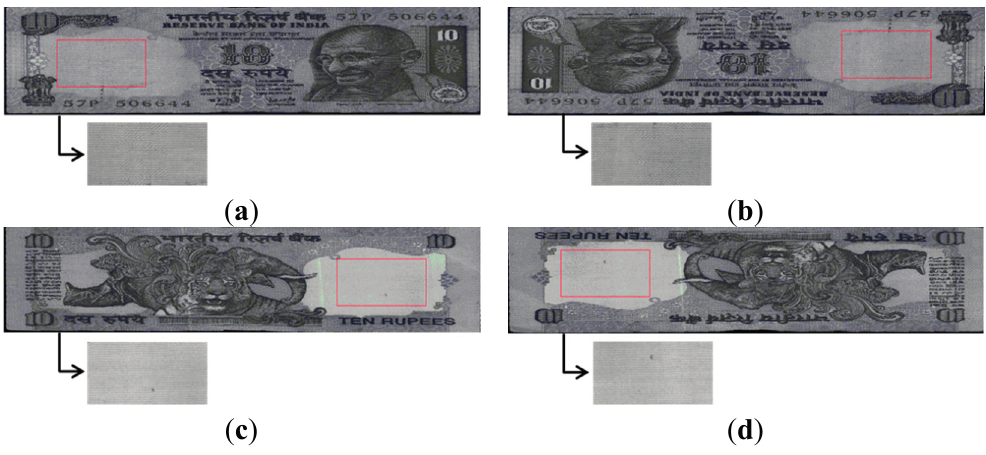
Figure 2. Example of input images in 4 directions and corresponding ROIs of a